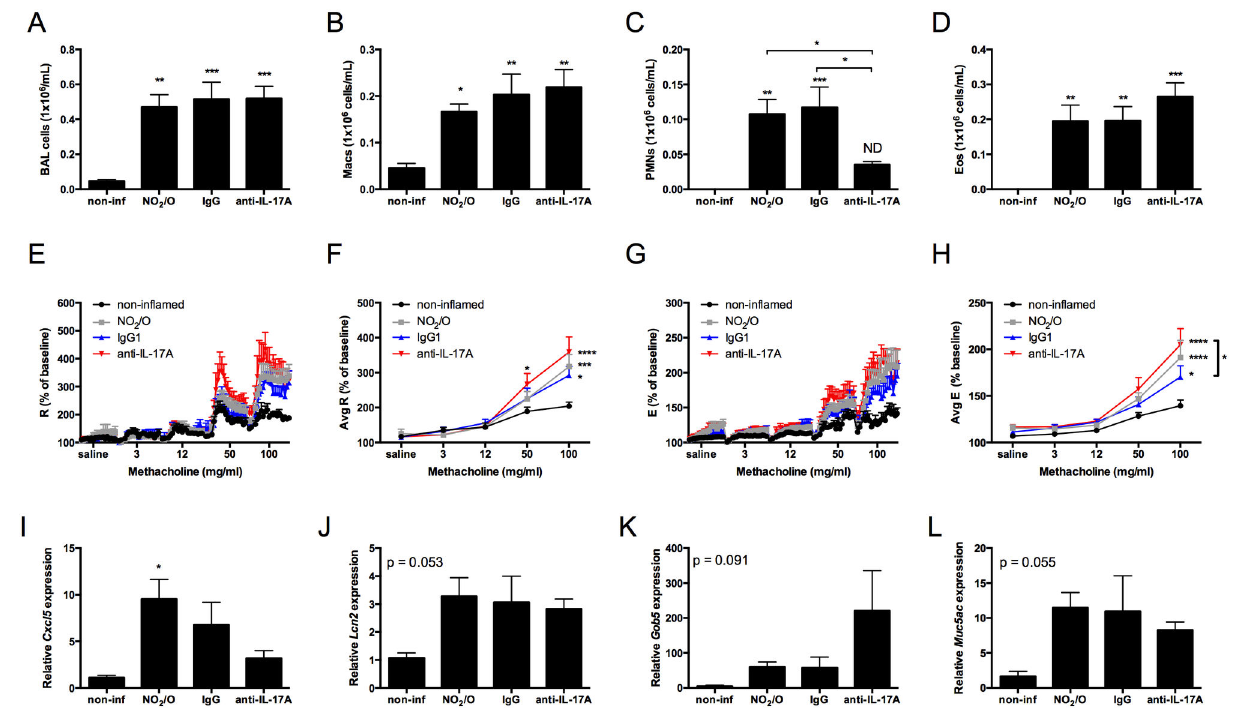
Figure 1. IL-17A is required for airway recruitment of neutrophils but not AHR in NO -promoted allergic airway 2 disease. C57BL/6 mice were exposed to 15ppm NO for 1 hour on day 1. All mice were exposed to OVA on days 1-3 and again 2 during challenge on days 14-16. Treatment groups received either IgG isotype control antibody or anti-IL-17A neutralization antibody one day prior to antigen challenge on day 13. 48 hours following the final antigen challenge, BAL total cells (A) were quantified and macrophages (Macs; B), neutrophils (PMNs; C), and eosinophils (Eos; D) were calculated based on cell fractions. Pulmonary function assessment was performed by invasive forced oscillation technique. The percent baseline and average percent baseline per dose methacholine were calculated for resistance (R; E-F) and elastance (E; G-H), as determined by the single- compartment model [47]. Lungs were removed and snap frozen prior to RNA analysis for Cxcl5 (I) , Lcn2 (J), Gob5 (K), and